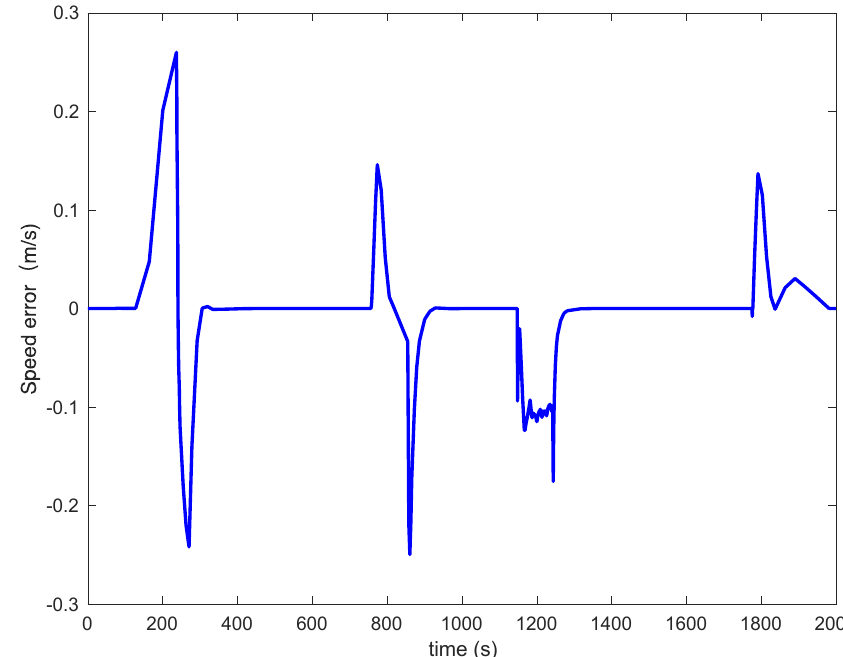
Figure 7. Speed error.